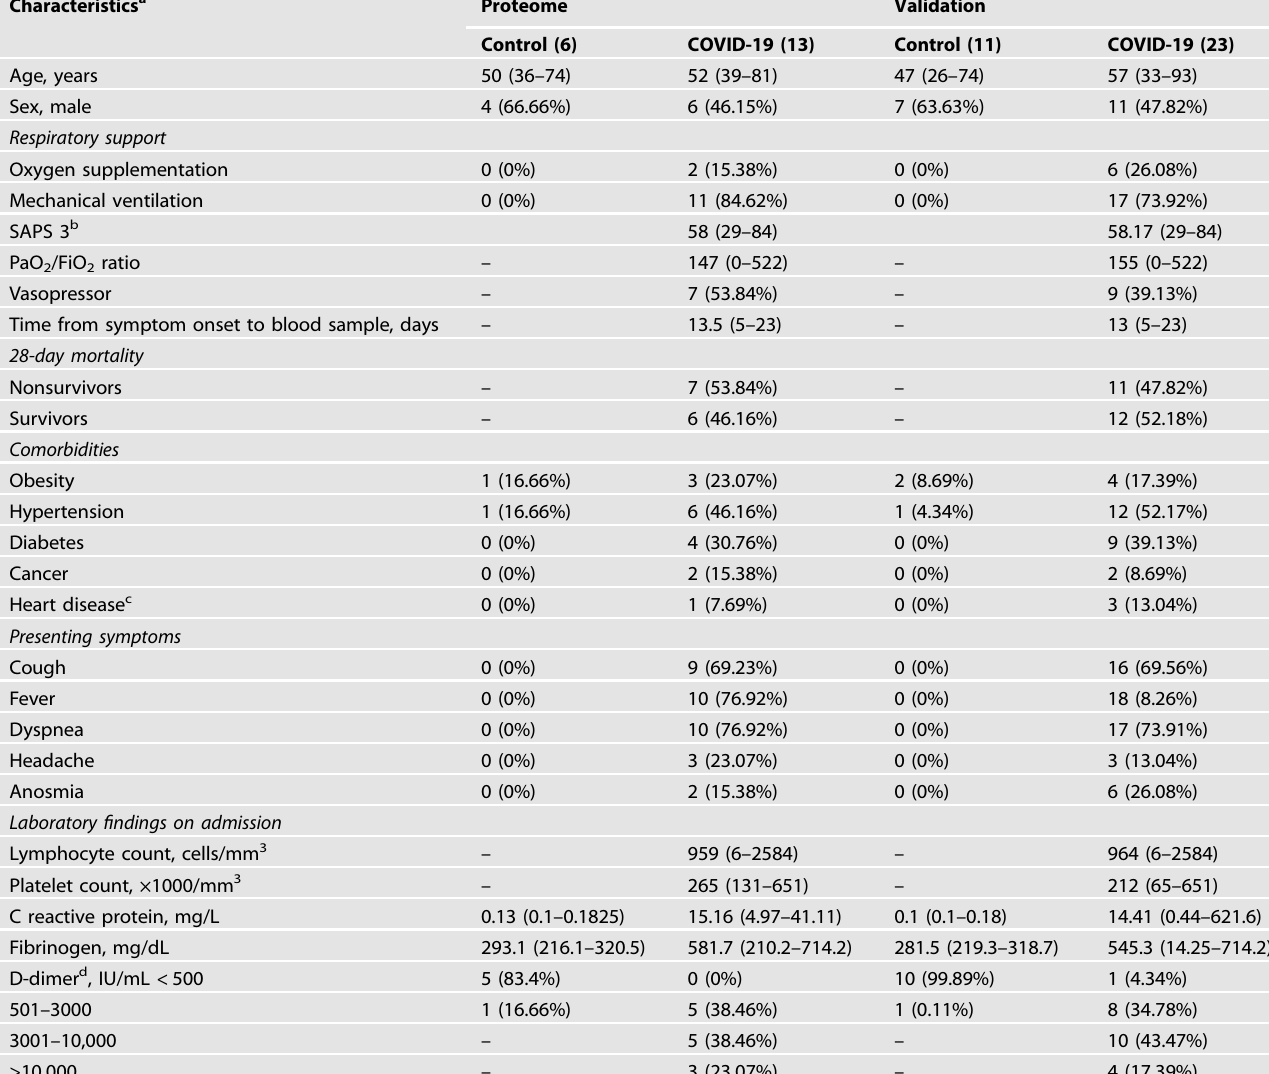
Table 1. Pro fi le of COVID-19 patients and control subjects in proteome and validation